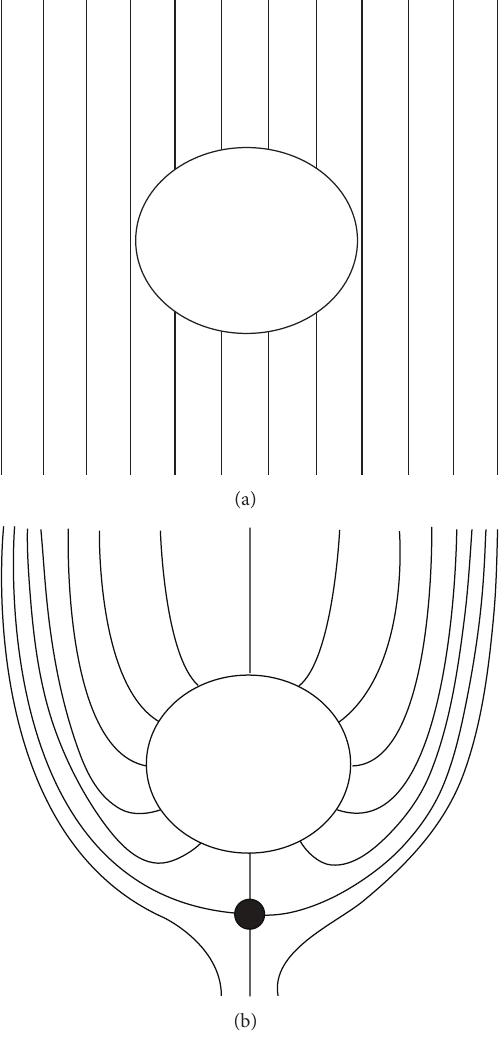
Figure 1: (a) In weak surface interaction limit an impurity does not essentially disturb LC environment. (b) Schematic presentation of topological defect dipole. The dipole is enforced by a spherical par- ticle enforcing homeotropic anchoring at the LC-particle interface. Consequently, from LC perspective the particle carries topological charge 𝑞 = 1 and can be viewed as a virtual topological defect. Due to the conservation of the total topological charge, an antidefect appears in the vicinity. The defect and antidefect attract each other but cannot mutually annihilate due to the virtual character of the defect. Note that the particle in absence of LC does not enforce any local orientational preference. However, topologically enforced formation of anti-defect necessarily breaks the initial isotropic